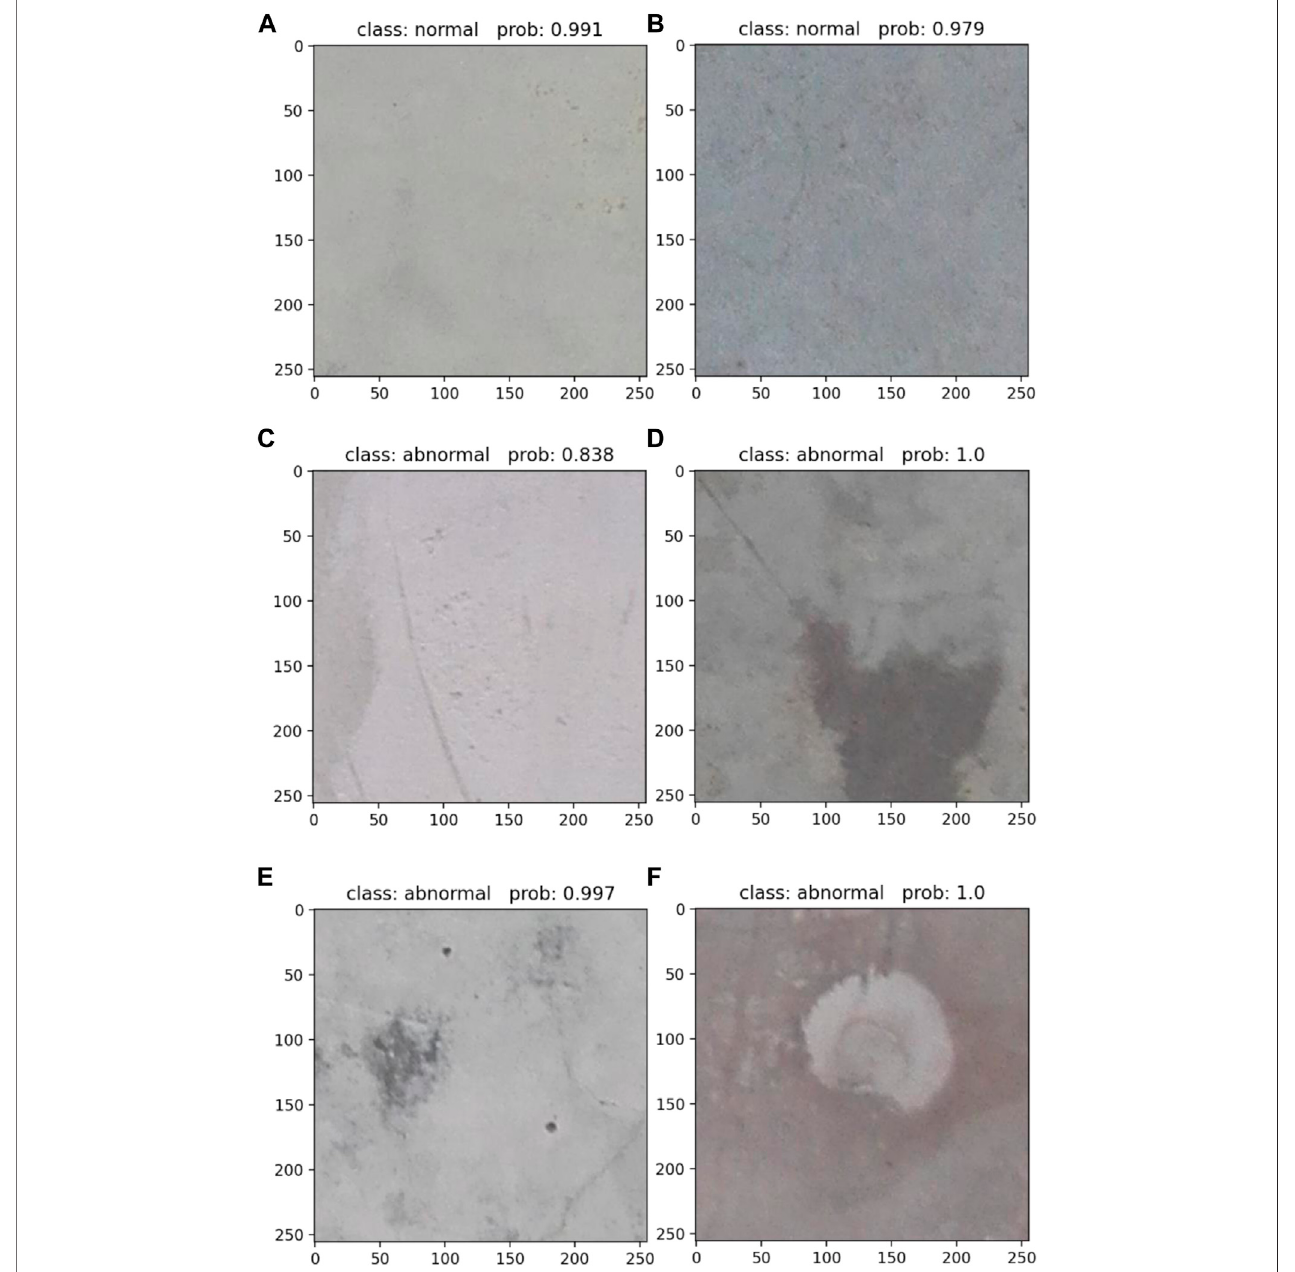
FIGURE11| Prediction results ofdifferent FFC chromatic aberration defects categories: (A) Light color without chromatic aberration output (B) Dark colorwithout chromatic aberration output (C) Light color incomplete chromatic aberration output (D) Dark color incomplete chromatic aberration output (E) Light color complete chromatic aberration output (F) Dark color complete chromatic aberration